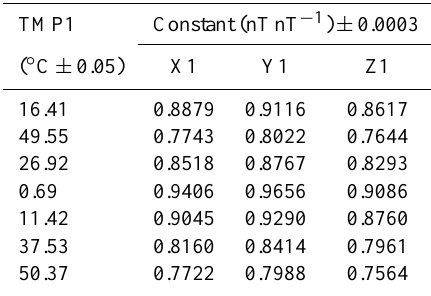
Table 11. Offset coils constants at the different